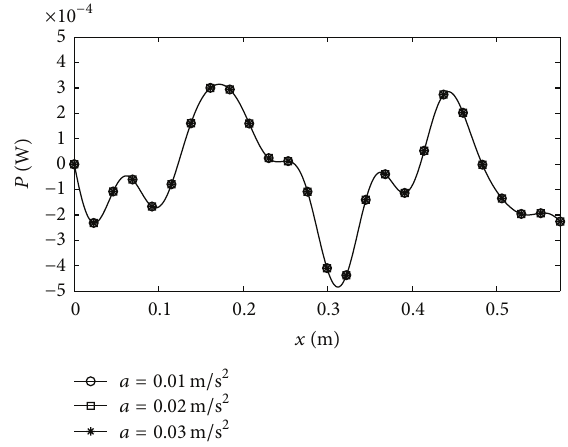
Figure 10: Vibration power flow of the FRMEJ with different accelerations under disturbance excitations.